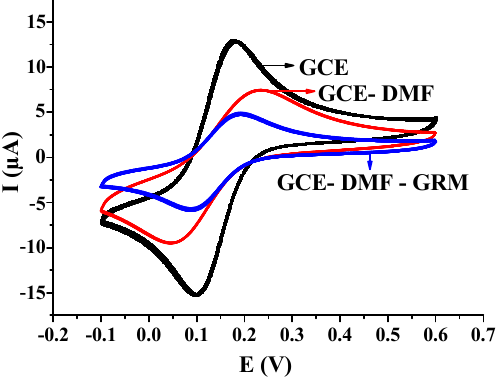
Figure 2. Cyclic voltammetry characterization of the ginseng root-meristem sensor. Abbreviation: GCE, glassy carbon electrode; DMF, durapore membrane filters; GRM, root meristem of Panax ginseng.